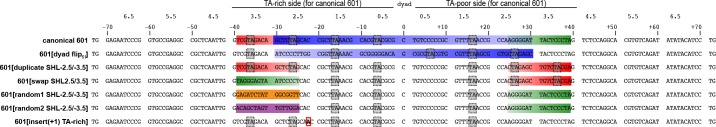
DNA sequences of 601 variants used in this study.Sequence information for the core 145 bp of the canonical and variant 601 positioning sequences used in this study (5’ to 3’). Periodic TA steps are indicated with gray dotted boxes, and colored segments highlight sequence elements that are altered in 601 variants, corresponding to the cartoons in Figure 4. The red box indicates the inserted A/T bp for the variant 601[insert(+1) TA-rich]. These core segments were made into double-labeled Cy5/FAM 40N40 nucleosomes using primers that matched flanking DNA in the original Widom 601 plasmid: 5’-/Cy5/AGTTCATCCCTTATGTGATGGACCCTATAC on the TA-rich (left) side, and 5’-/6FAM/ATCCGACTGGCACCGGCAAGGTCGCTGTTC on the TA-poor (right) side.